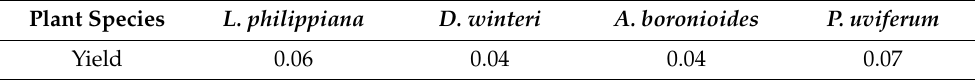
Table 5. Yields of essential oils (mL/100 g) extracted from the four Patagonian plant species. Plant